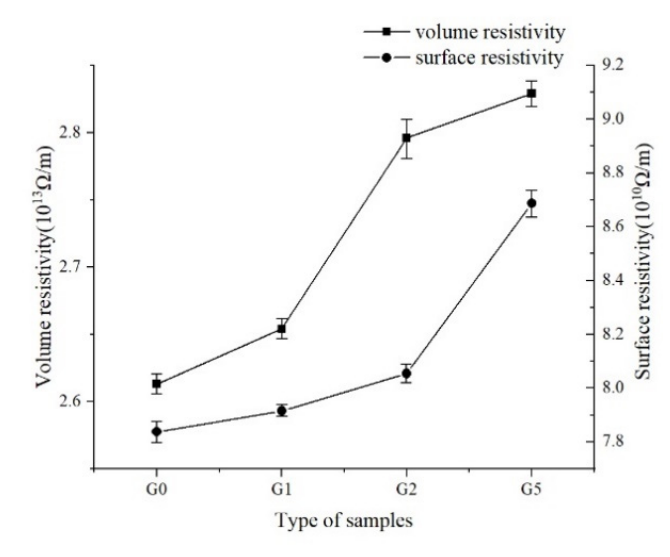
Figure 9. Surface resistivity and volume resistivity.